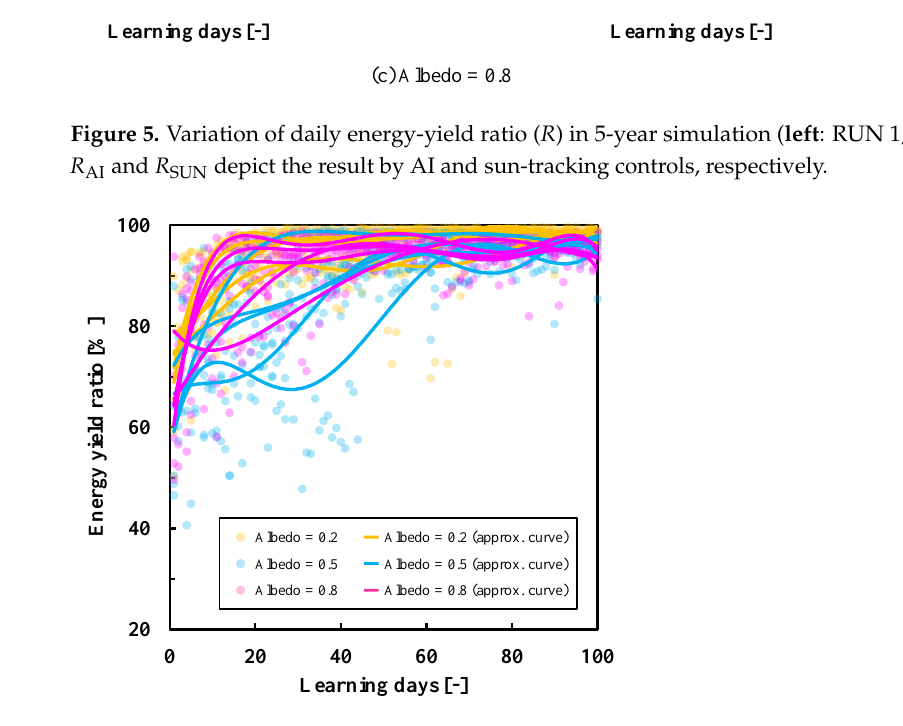
Figure 7. Box plot of daily energy-yield ratio in 5-year simulation (RUNs 1 – 10). Figure 8 shows the 5-year R averaged over all RUNs as a stacked bar graph depicting the breakdown of the front and rear contributions. The AI control shows energy-yield rates of 97.4%, 96.0%, and 94.2% for albedo = 0.2, 0.5, and 0.8, whereas the sun-tracking control shows 98.2%, 92.0%, and 85.0%, respectively. For albedo = 0.2, the AI control is slightly lower than the sun-tracking control; however, for albedo = 0.5 and 0.8, it is 4.0% and 9.2% higher, respectively. The advantage of AI control for high-albedo cases can be attributed to the increase in rear gain. Sun-tracking control cannot effectively utilize the rear gain for high-albedo cases. The decrease in the absolute value of R AI for higher albedo